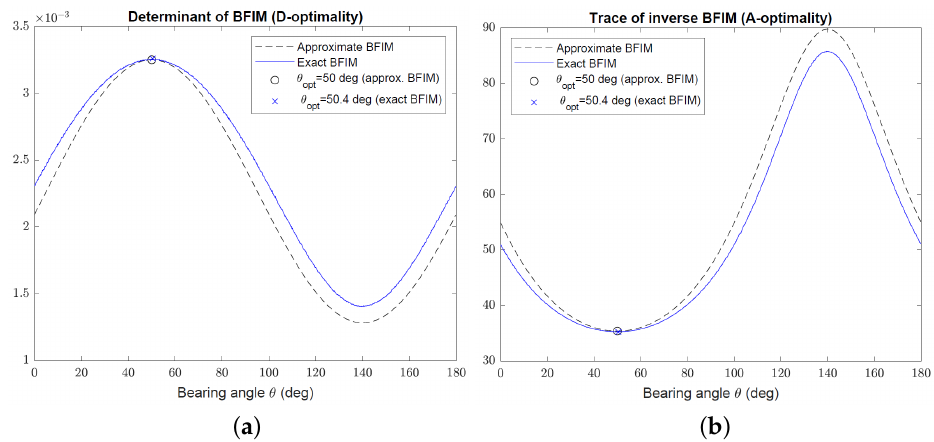
Figure 7. ( a ) Plot of determinant of Φ (D-optimality criterion) versus bearing angle for large P 0 using approximate and exact BFIM. ( b ) Plot of trace of Φ − 1 (A-optimality criterion) versus bearing angle for large P 0 using approximate and exact